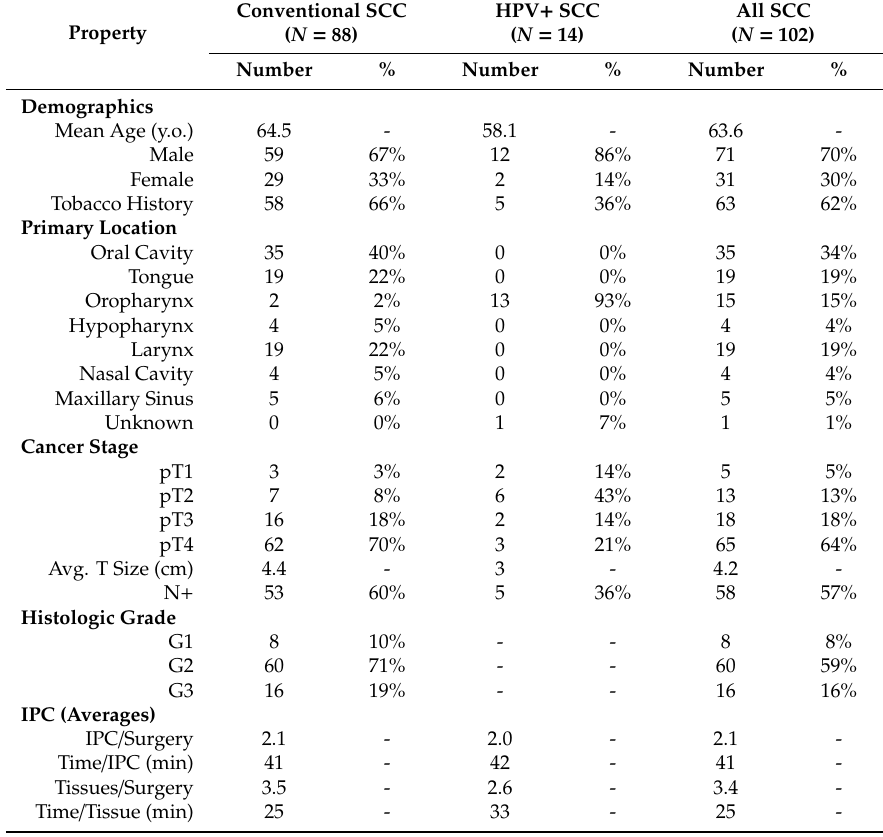
Table 1. Demographics and cancer properties for the patients recruited for this study. Values are reported for the two cohorts, conventional SCC with variants and p16 + SCC, separately and combined. Percentages for conventional are out of 88 patients, HPV + out of 14 patients, and combined out of 102 patients. TNM staging was not available for one patient in the HPV + cohort. All cases were M0. Tobacco history represents current or past smoking or chewing tobacco